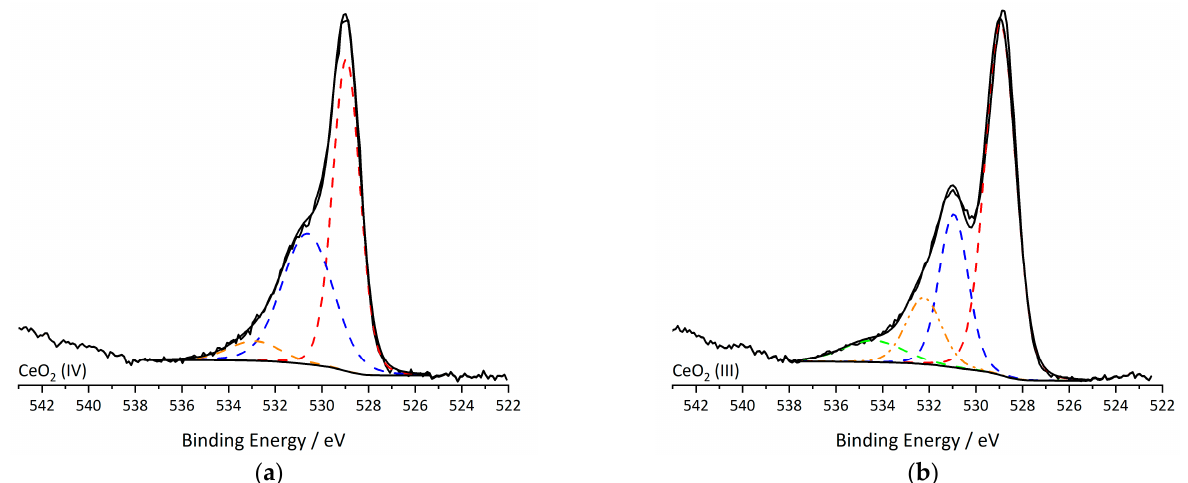
Figure 10. X-ray photoelectron spectra of O 1s peaks for calcined ( a ) CeO 2 (IV) and ( b ) CeO 2 (III) catalysts, where fitting shows the O α (red), O β (blue) oxygen species as described in the main text and yellow and green refer to the overlapping Na Auger peaks.